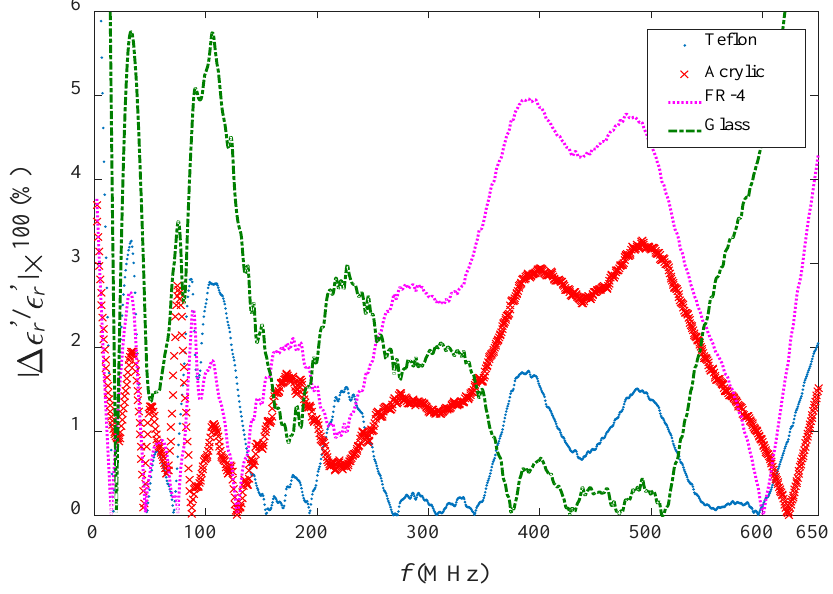
Table 4. Expected values for ε r ′ and tan δ .